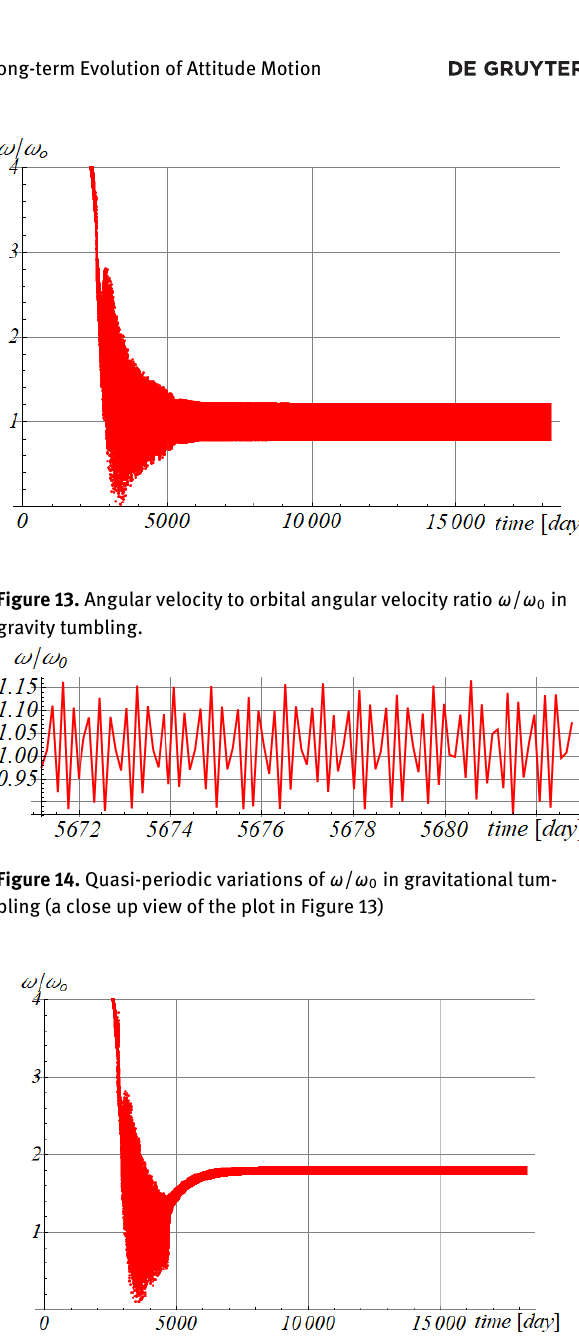
Figure 15. Angular velocity to orbital angular velocity ratio ω / ω 0 in case of eddy-current rotation final